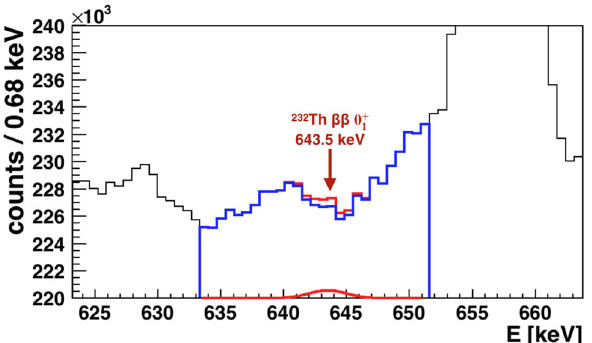
Fig. 4 Regionofinterestandfitforthe0 + transition.Thedataisshown 1 in black. The mean background expectation in each bin identical to the data by construction is shown in blue. The signal peak excluded by 90% probability is shown in red on of the data as well as independently at the bottom